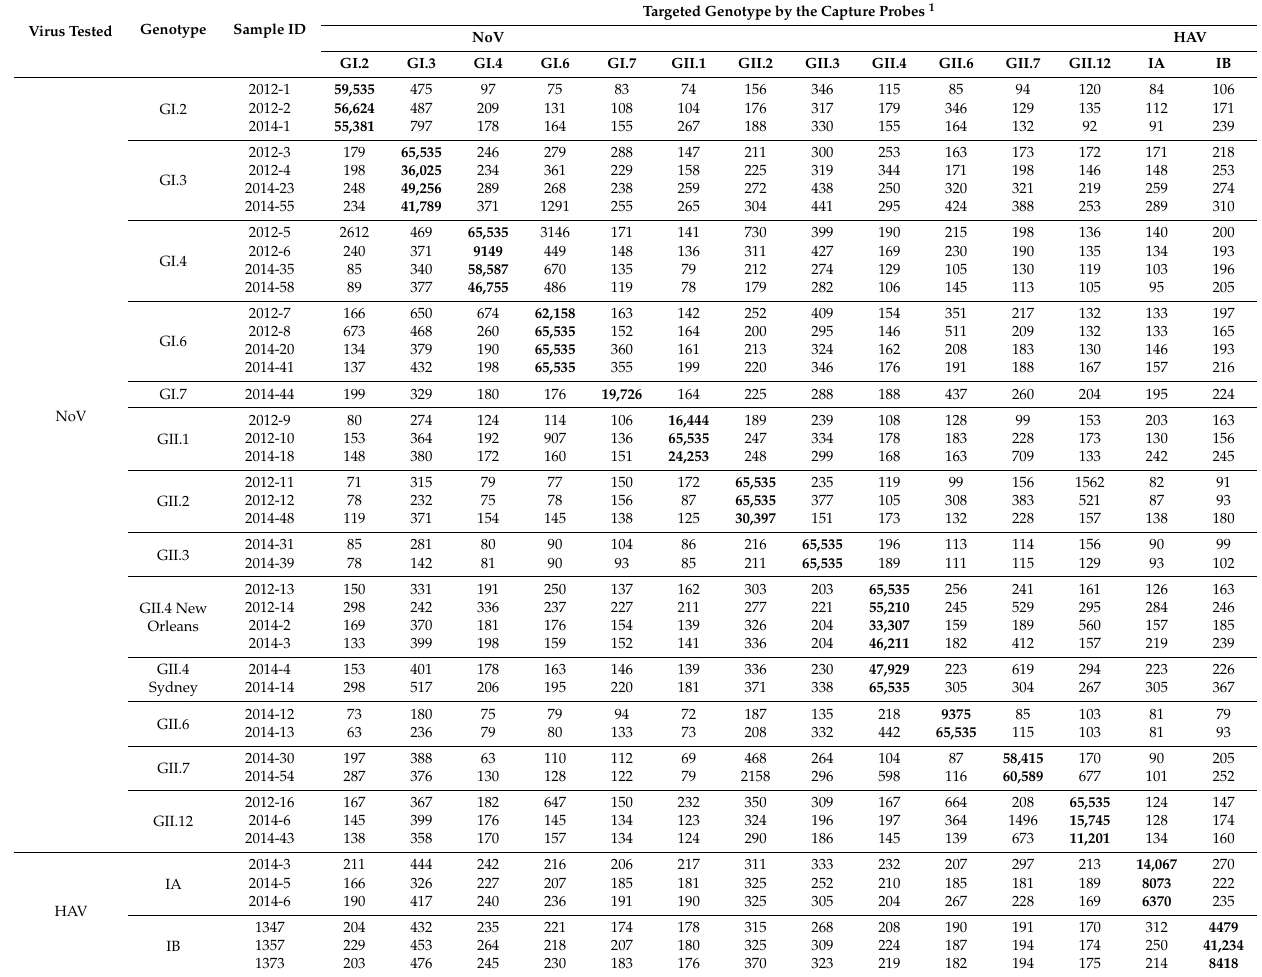
1 Fluorescent signals detected for genotype-specific probes are shown in